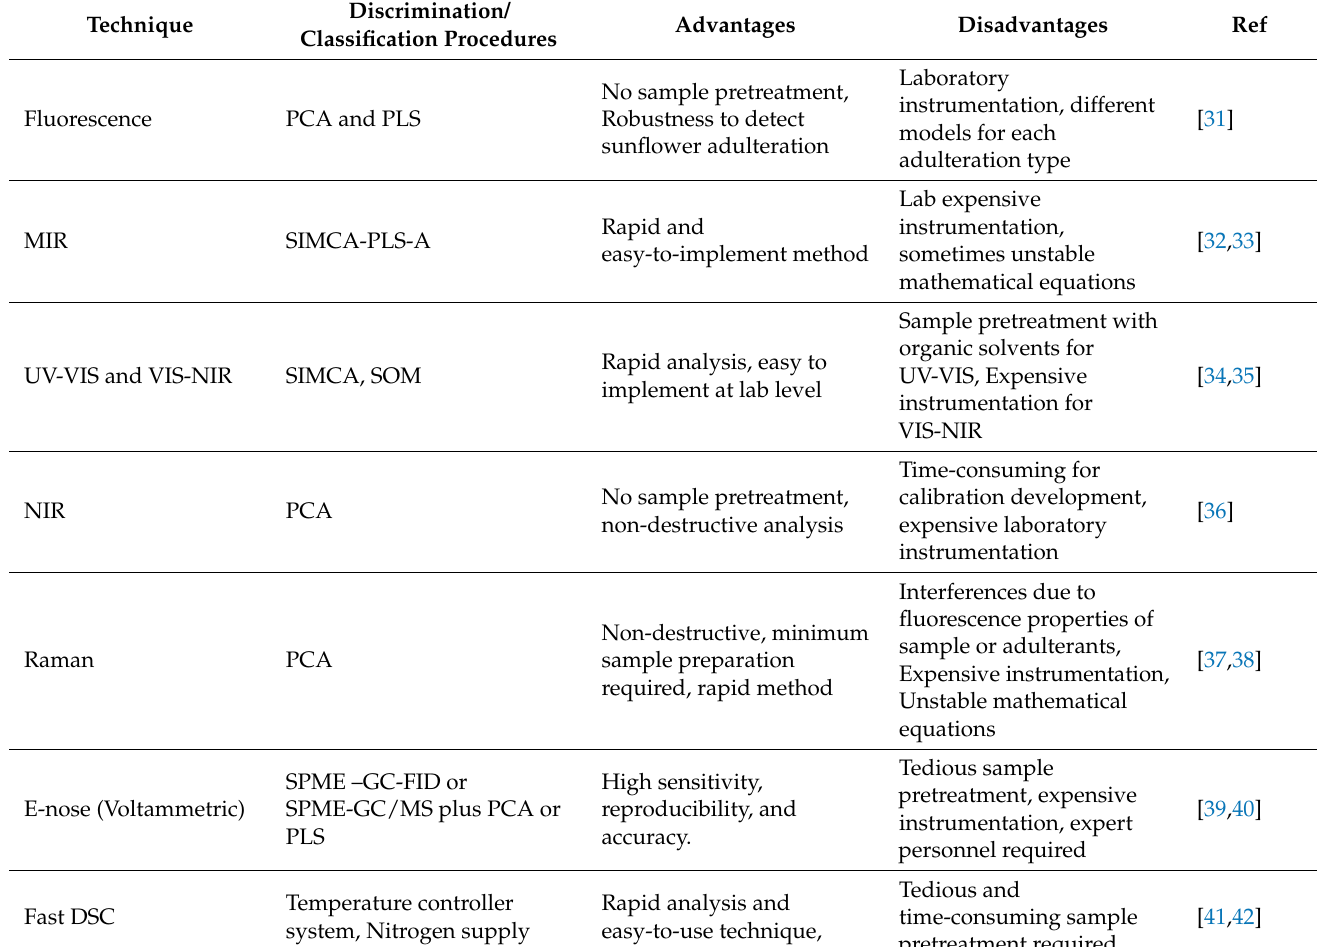
Table 4. Analytical techniques proposed to detect olive oil